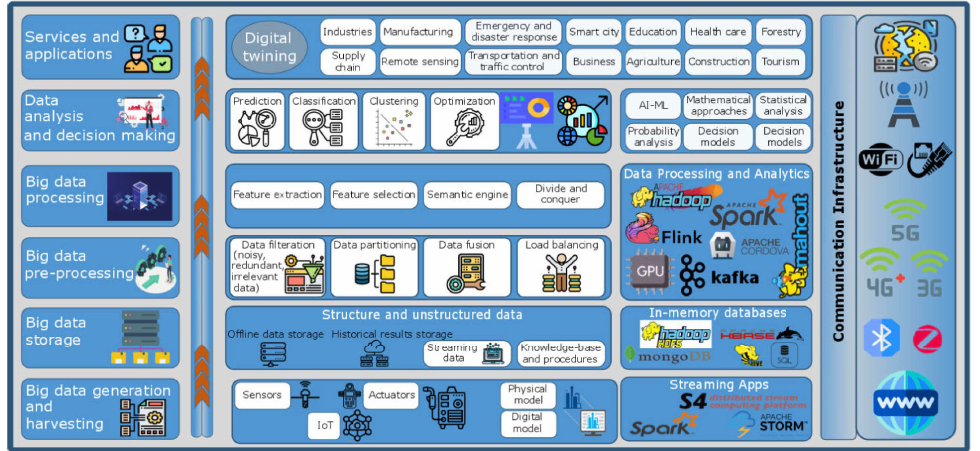
Figure 4. Representative map of features of DT using big data and ML approaches. Several applications and fields are presented, as well as the main technologies and communication infrastructure